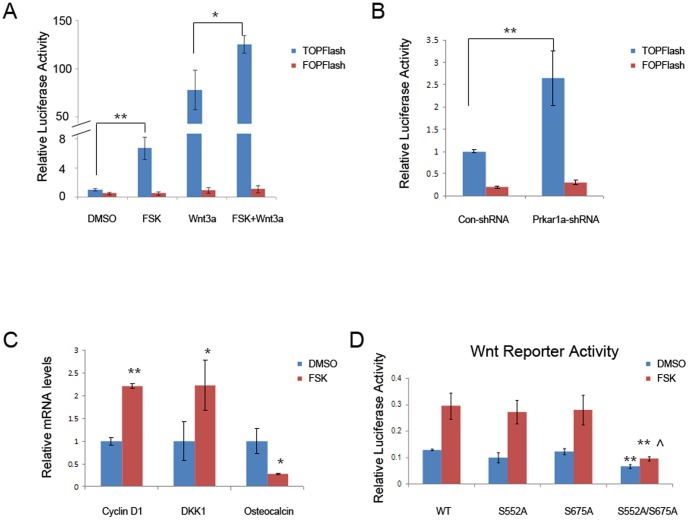
PKA activation enhances basal and stimulated Wnt/β-catenin -dependent transcriptional activity in MC3T3-E1 cells.A. Cells were transfected with a Wnt/β-catenin -reporter plasmid (TOPFlash) or the same plasmid with a mutation in the Wnt-responsive elements (FOPFlash). Luciferase assay was performed following treatment with vehicle, FSK, or Wnt3a (100 ng/ml) as indicated (* P<0.05, ** P<0.01). B. Luciferase assay was performed in cells with control or Prkar1a knockdown to measure the Wnt/β-catenin-reporter activity (** P<0.01). C. mRNA expression of Wnt/β-catenin target genes was determined using QPCR analysis. The expression of each was normalized to GAPDH expression (** P<0.01 versus DMSO treated cells). (D) Cells were transfected with TOPFlash or FOPFlash along with FLAG-tagged β-catenin or its PKA phosphorylation mutants, as indicated. The Wnt/β-catenin -reporter activity was measured by luciferase assay following stimulation of cells with forskolin. (** P<0.01 versus WT or single mutants, ∧ P<0.05 versus DMSO treated counterparts).